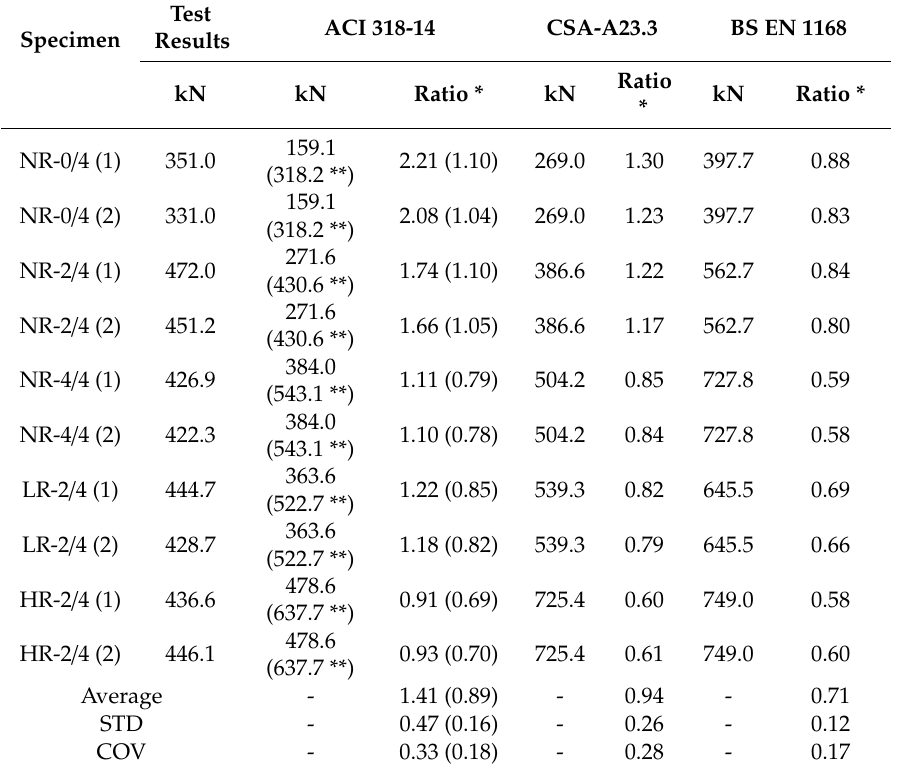
Table 5. Comparison of test and calculation